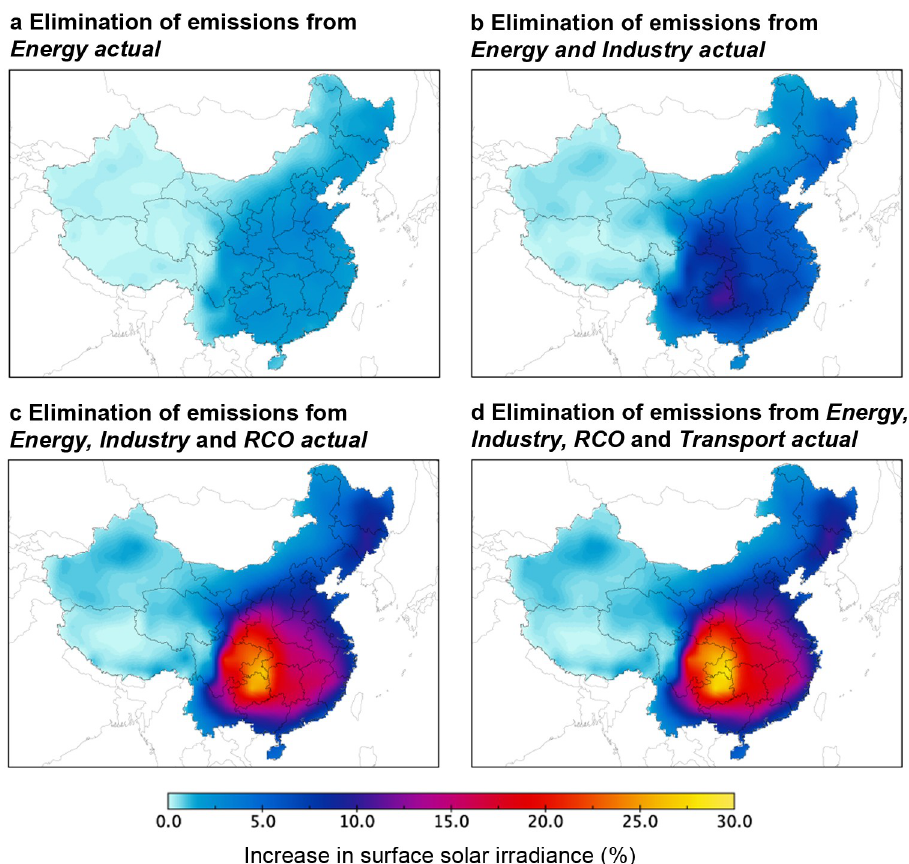
industrial and residential and commercial (RCO) sectors (c), and of actual emissions from energy, industrial, RCO, and transport sectors (d). Data and material from [19,